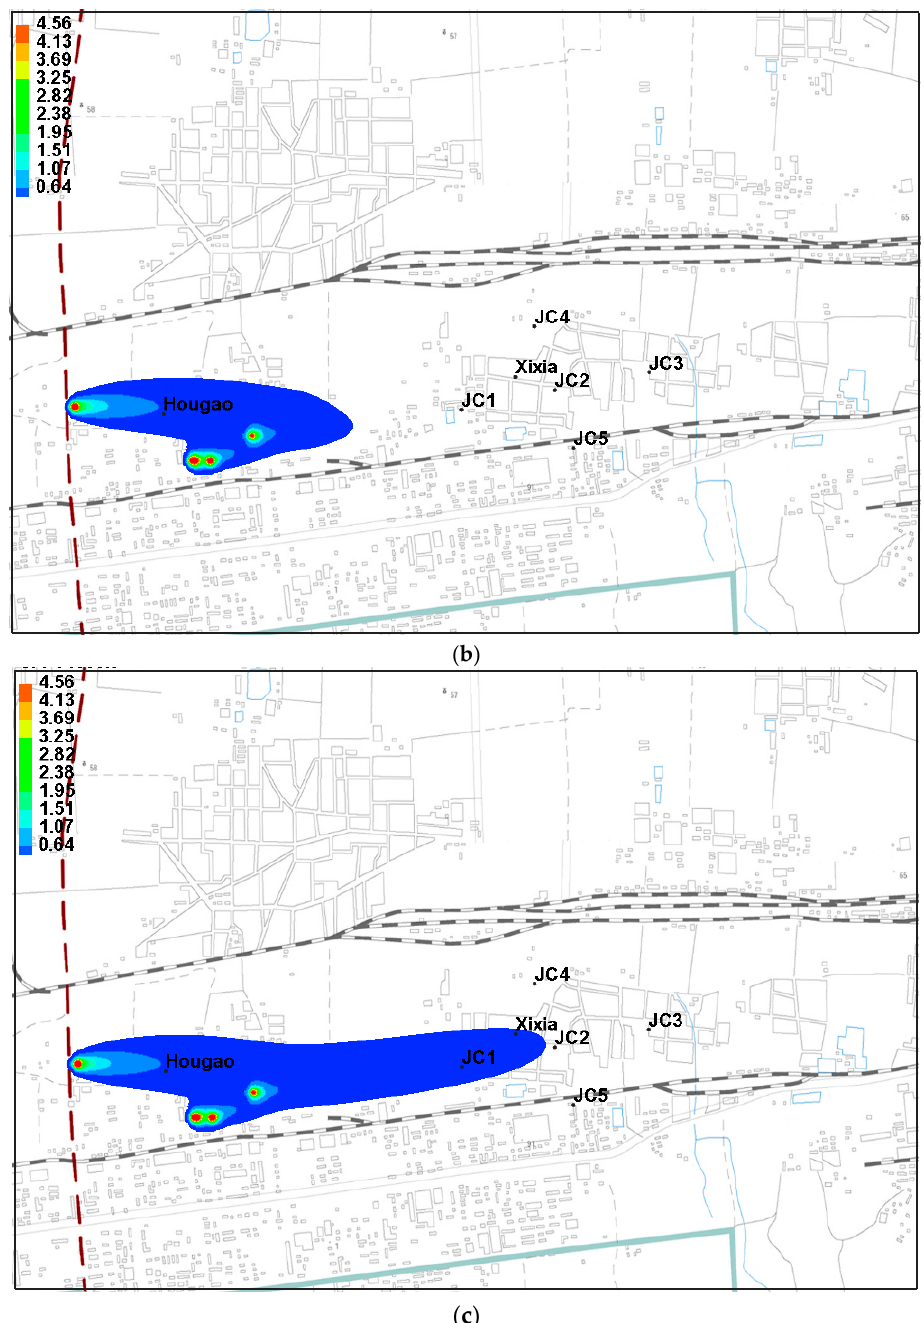
Figure 12. Prediction diagram of ammonia nitrogen transport in the four Hougao wells with strong pumping; ( a ) five years; ( b ) ten years; ( c ) twenty years .